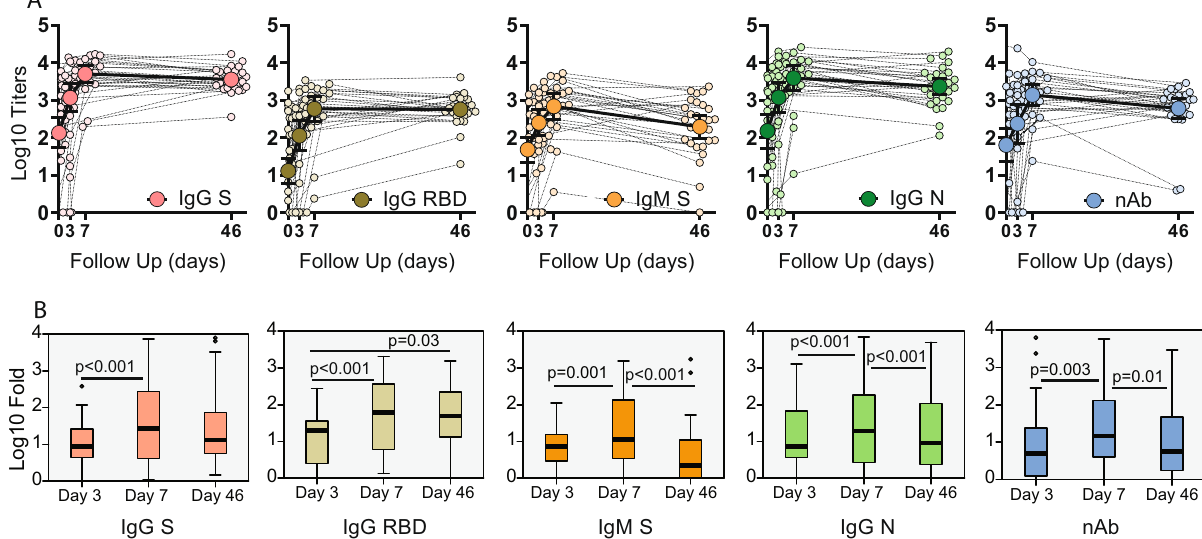
Fig. 1 Longitudinal antibody response to SARS-CoV-2 antigens. Serum from hospitalized COVID-19 patients was analyzed at baseline, at hospital recruitment and days 3 and 7. A subsequent sample was collected in the convalescence period in the COVID-19 survivors with mean time of 46 days. A Longitudinal pro fi le of antibodies against SARS-CoV-2. Antibody titer was quanti fi ed as area under the curve (AUC) after serial serum dilution for each sample (Supplementary Fig. 1). Calculated AUC at each time is shown to quantify changes over time for each individual (small dots) against immunoglobulin G (IgG) spike, IgG receptor-binding domain (RBD), immunoglobulin M (IgM) spike and IgG nucleocapsid (N); and neutralizing activity (nAb) as inhibitory concentration 50% (IC50%). Geometric mean titer (GMT, big dots) and con fi dence interval (CI 95%) are also shown. B Boxplot diagram of geometric mean fold rise (GMFR) antibody titers against SARS-CoV-2 at the same time points: IgG spike, IgG RBD, IgM spike and IgG NP; and neutralizing activity (nAb). Related-samples Friedman ’ s two-way ANOVA was performed. Signi fi cant adjusted p values after pairwise comparisons are shown for each comparison. Black bar indicates GMFR values, box indicates IQR (Q1 – Q3), lines indicate minimum and maximum. Outliers from the observed distribution are shown. Total n = 116 biologically independent serum samples (day 0 = 37, day 3 = 29, day 7 = 22, day 46 = 28). n = 116 biological samples examined against four different SARS-CoV-2 substrates for ELISA assays; ELISAs for each substrate were run once each. N = 116 serum samples examined over two independent experiments for neutralization assays.